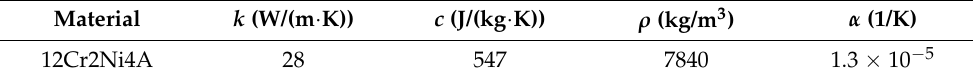
Table 3. Thermophysical parameters of the gear.